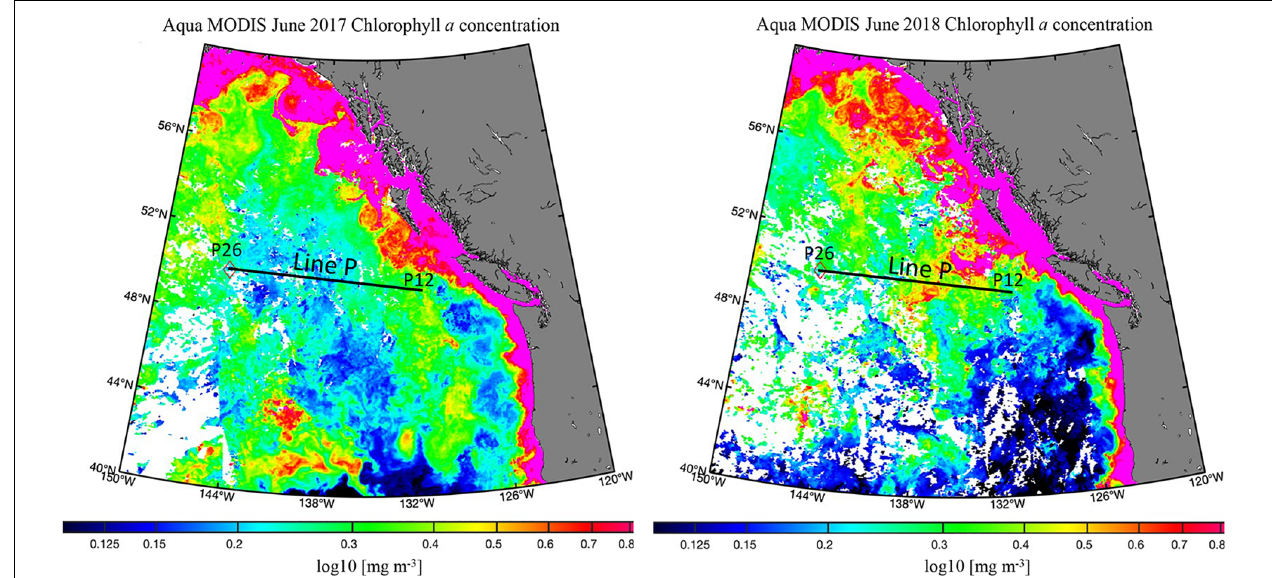
FIGURE 5 | Satellite chlorophyll distributions [mg m − 3 ] for June 2017 and 2018. The analyzed portion of Line P is represented by a black line. Aqua MODIS data from https://oceancolor.gsfc.nasa.gov/l3/ (Hu et al., 2012). Map made with M_Map